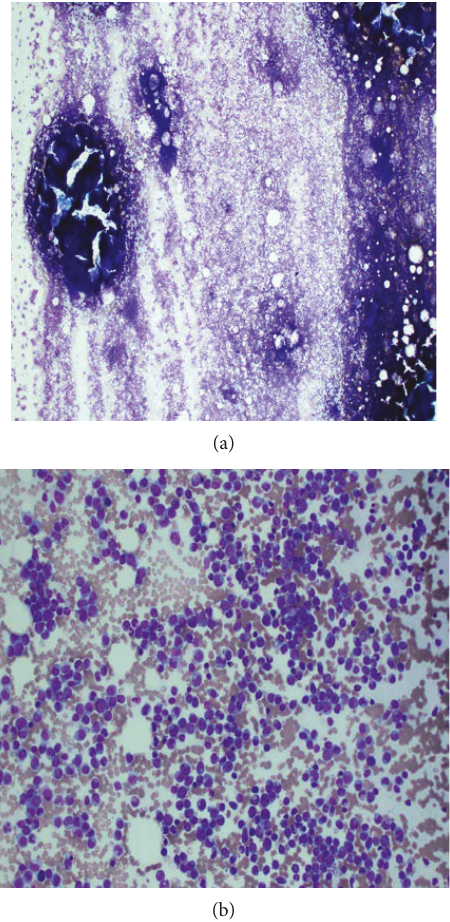
Figure 2: Hypercellular bone marrow aspirate showing marked excess of blasts.